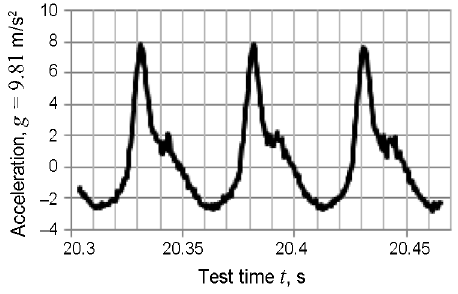
Fig. 1. Typical values of accelerations for the pile subjected to